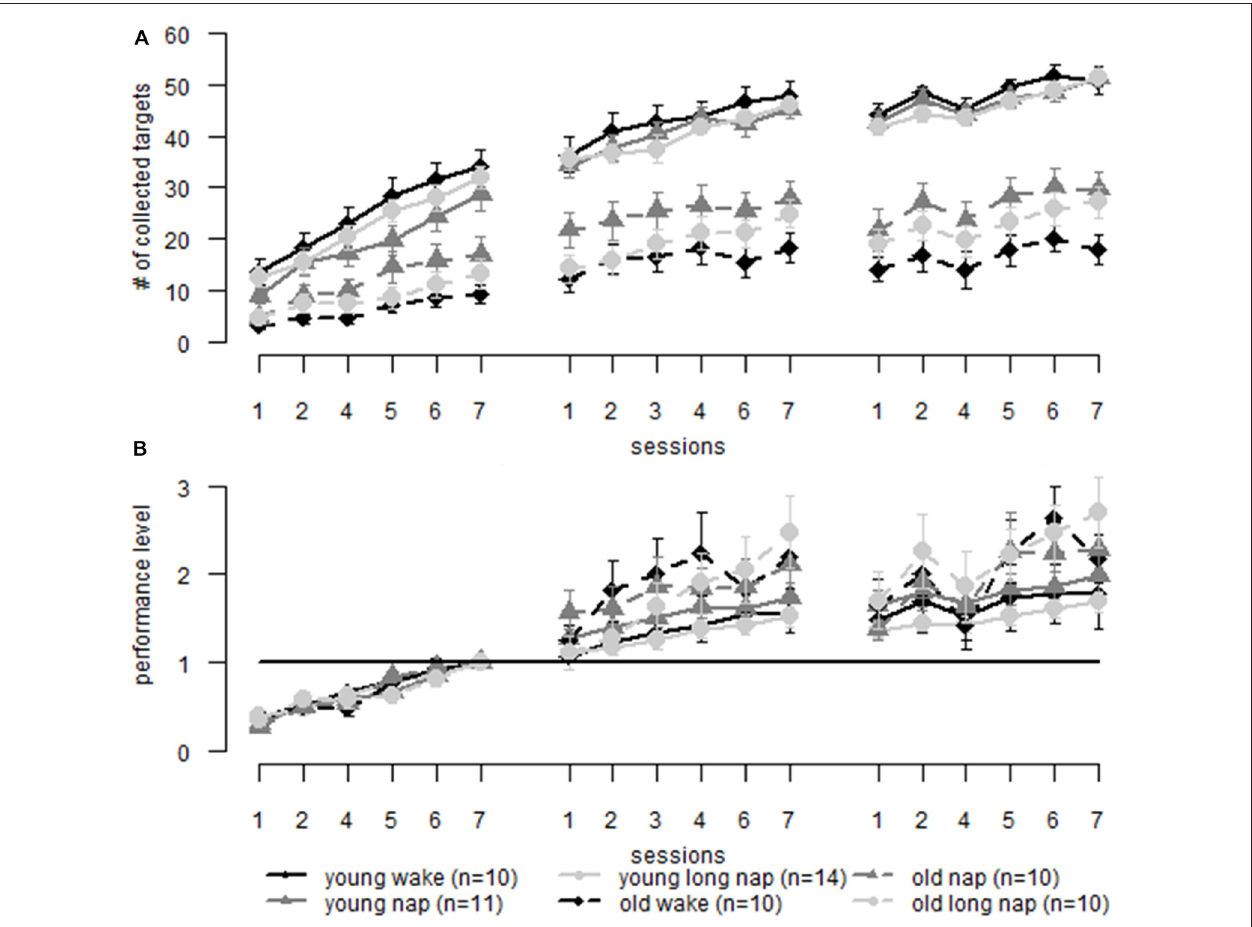
FIGURE 7 | Motor adaptation: comparison of learning in older (dotted lines) and younger adults (solid lines) over three learning sessions including a midday break (first gap) and over-night sleep (second gap). (A) Raw data comparing young and older adults. (B) Data is normalized to the same pre-sleep level of learning. When the initial learning phase is eliminated the learning curves are similar to older and younger adults. Older adults show greater performance improvements than younger adults. Error bars represent the standard error of the